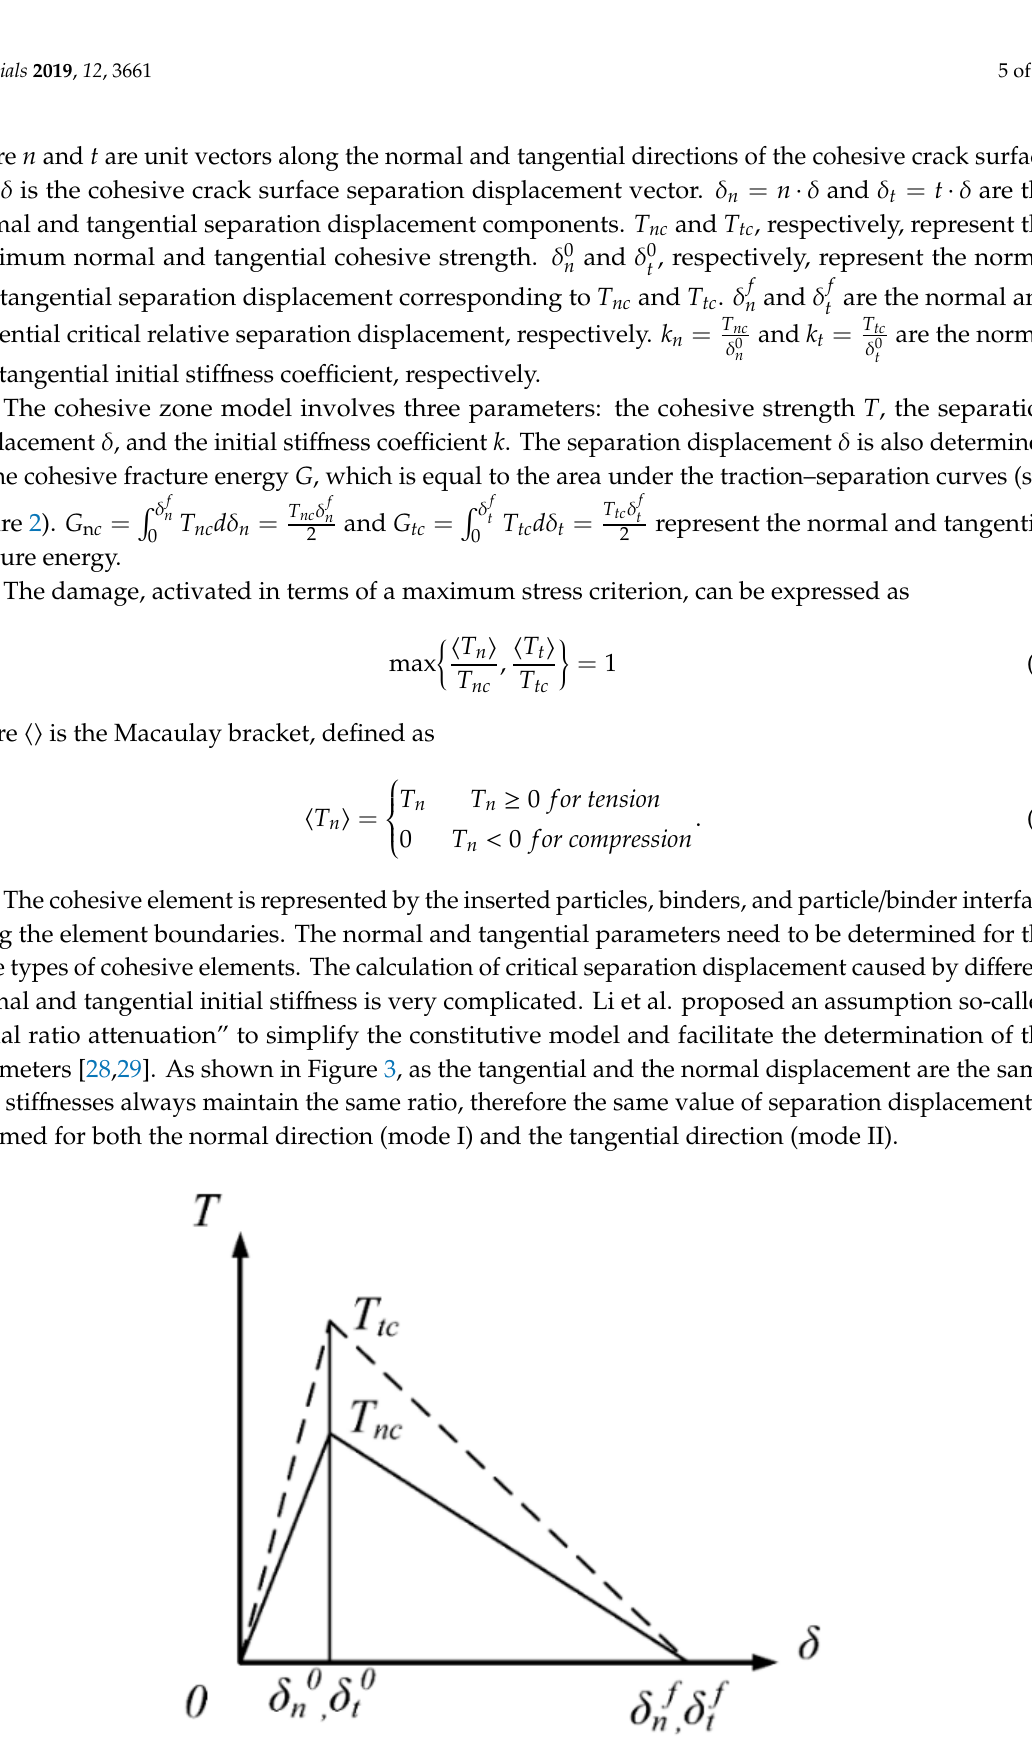
Figure 3. An assumption so-called “equal ratio attenuation”.